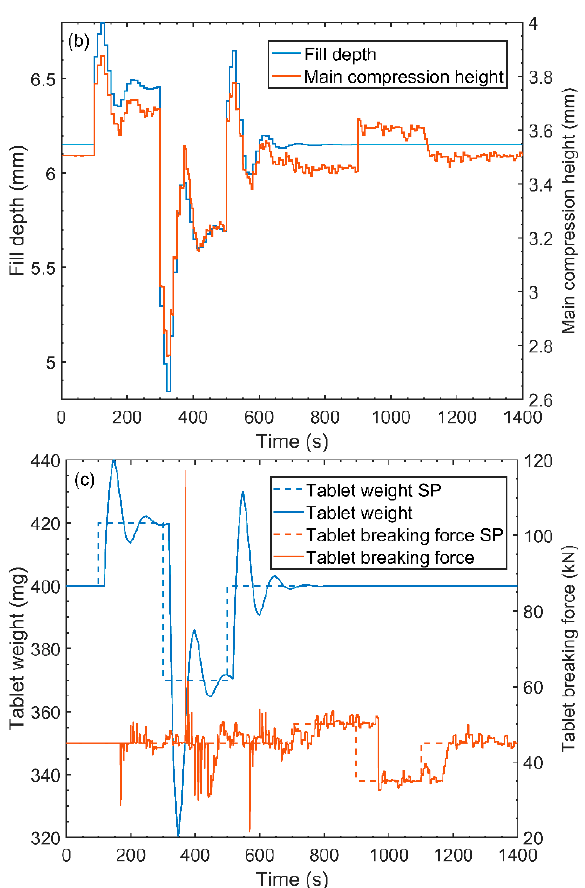
Figure 16. Control strategy 3—Set point tracking scenario. ( a ) Critical process parameters ( b ) Actuators ( c ) Critical quality attributes.